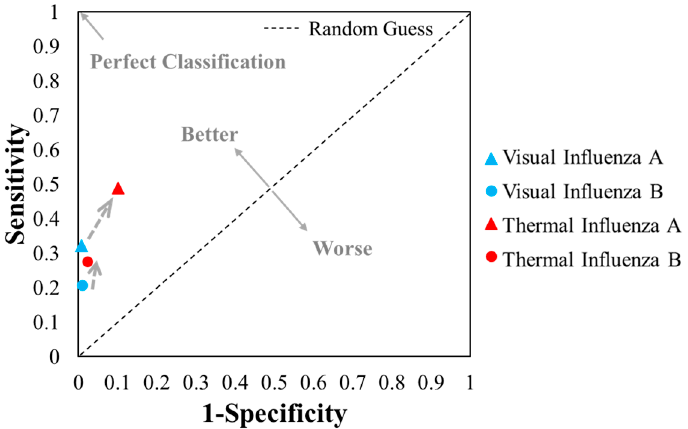
Figure 4. Plots of the 4 results from the visual and thermal contrast amplification (TCA) detection of influenza A and B (from Table 2) in the receiver operating characteristic space.